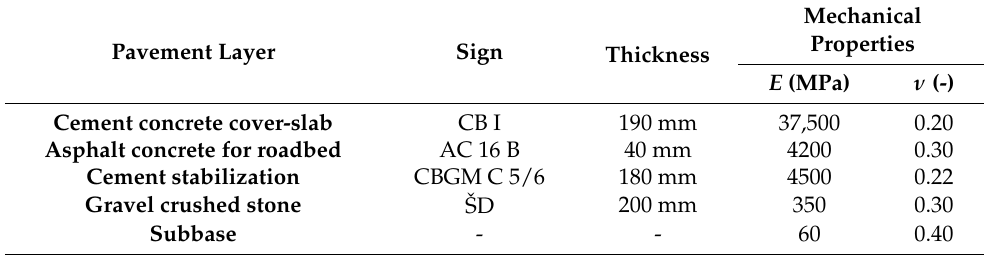
Table 3. Properties of CCP layers used for the numerical